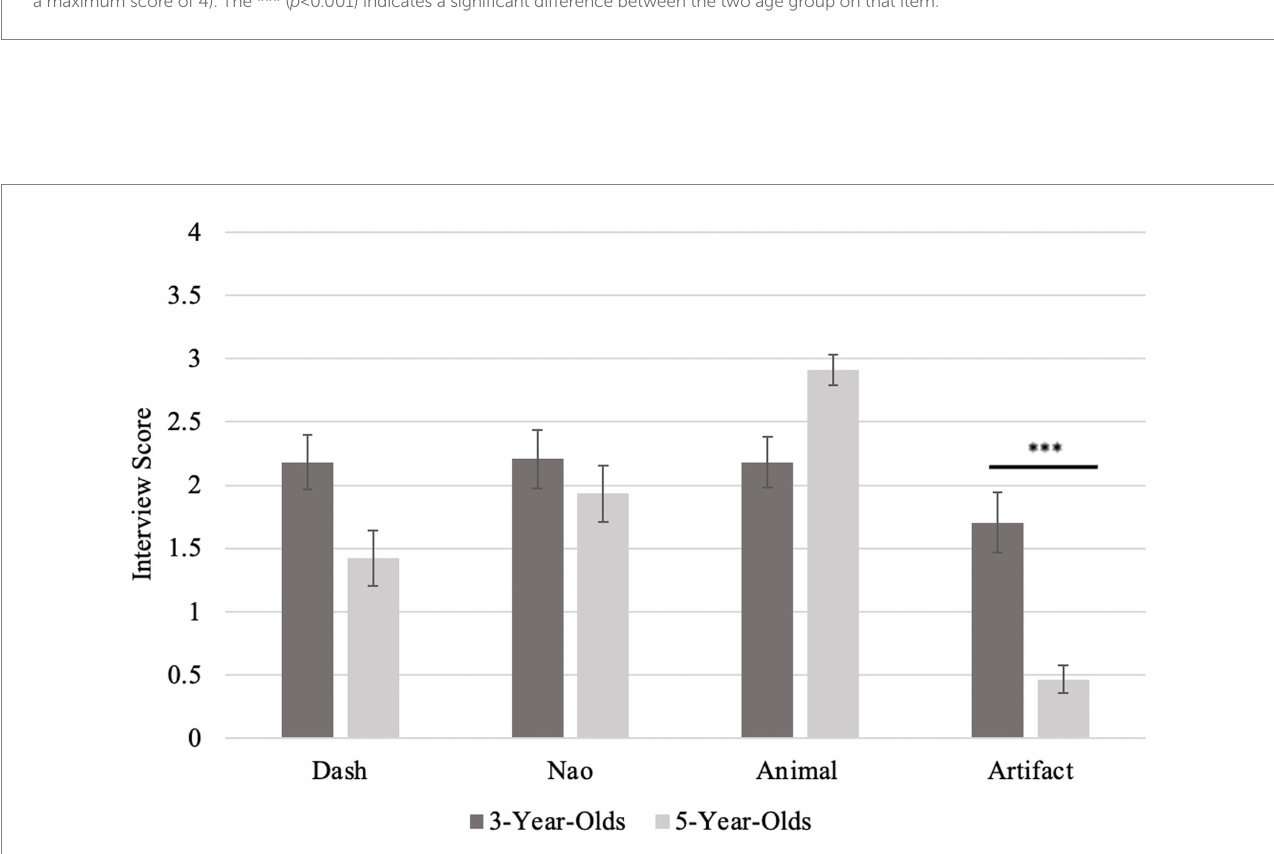
FIGURE 4 Score on Animacy Interview by item type, as a function of age. Error bars represent standard error. Higher scores represent more anthropomorphizing (with a maximum score of 4). The *** ( p <0.001) indicates a significant difference between the two age group on that item.